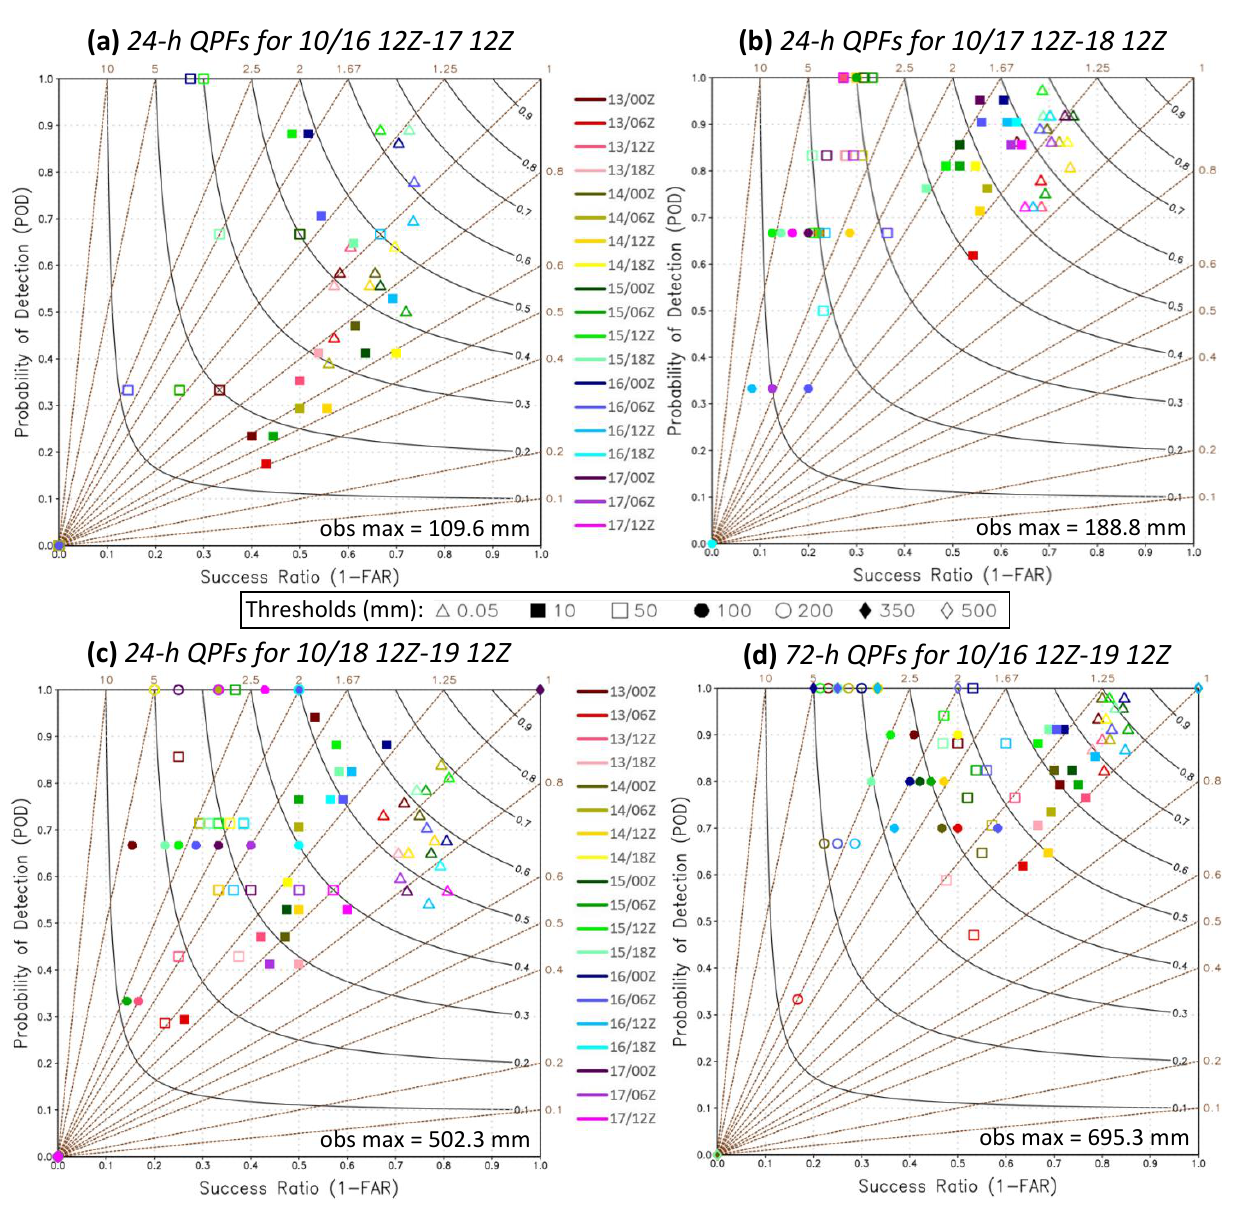
Figure 9. As in Figure 5a–c, except for 24 h QPFs targeted for ( a ) 1200 UTC 16–1200 UTC 17, ( b ) 1200 UTC 17–1200 UTC 18, and ( c ) 1200 UTC 18–1200 UTC 19 October 2015, and ( d ) 72 h QPFs for the combined period (for 1200 UTC 16–1200 UTC 19 October) during Koppu at six selected thresholds from 0.05 to 350 mm (symbol), plus 500 mm in ( d ).